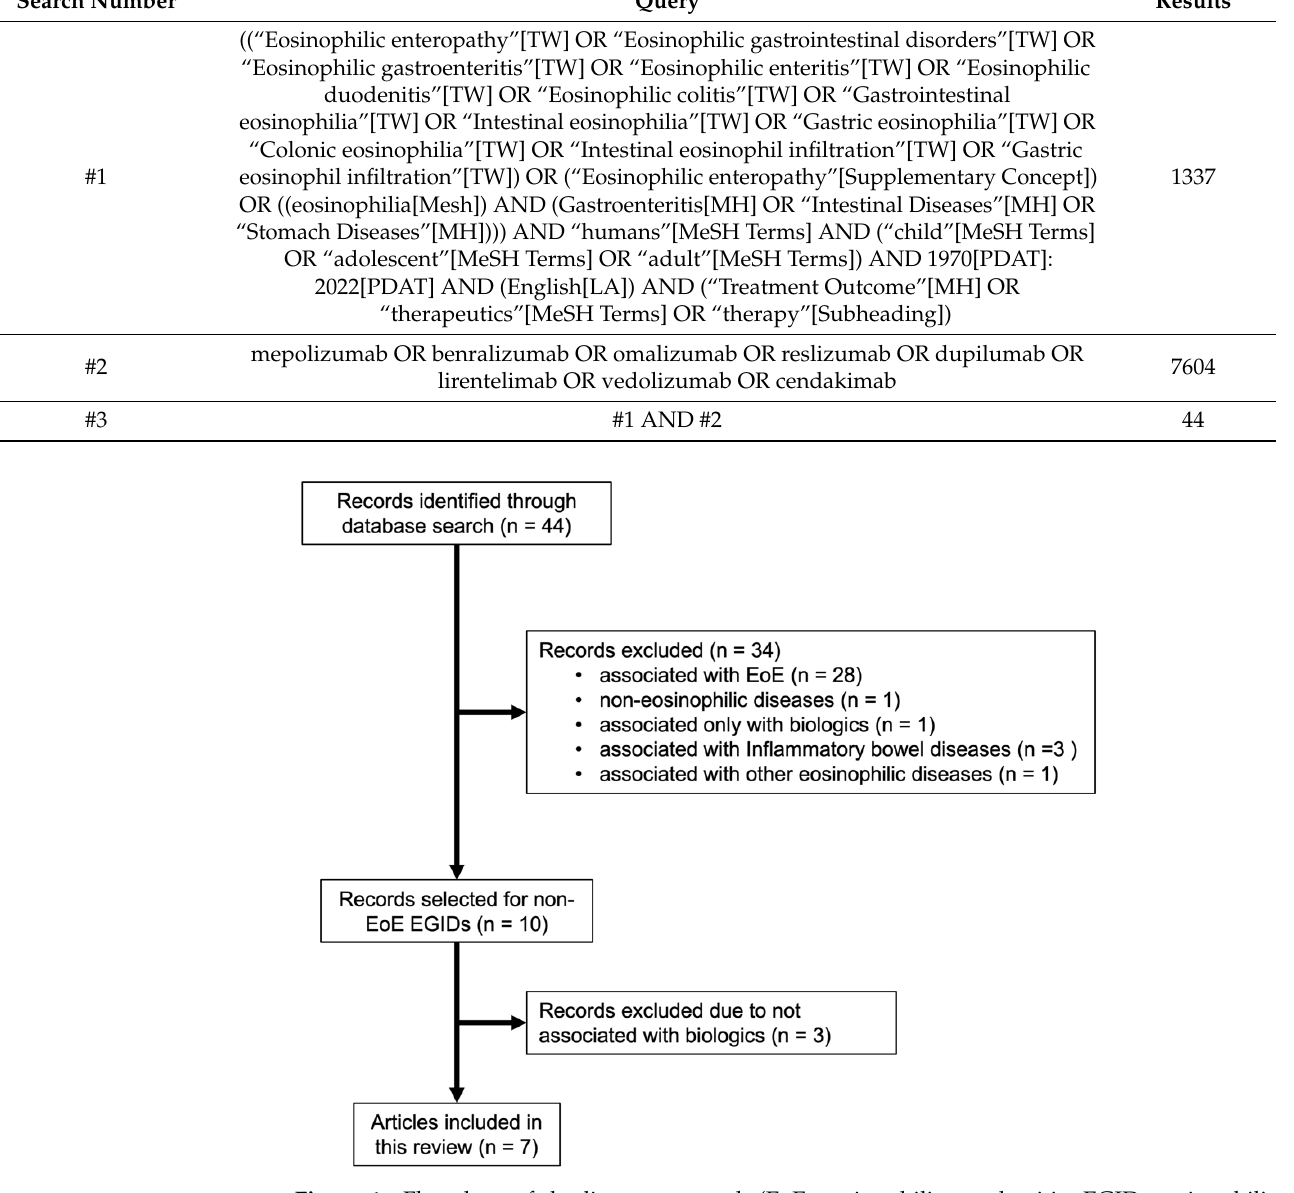
Figure 1. Flowchart of the literature search (EoE, eosinophilic esophagitis; EGID, eosinophilic gastrointestinal disorder). Table 1. Search strategy used for the systematic reviews conducted in this study (PubMed).